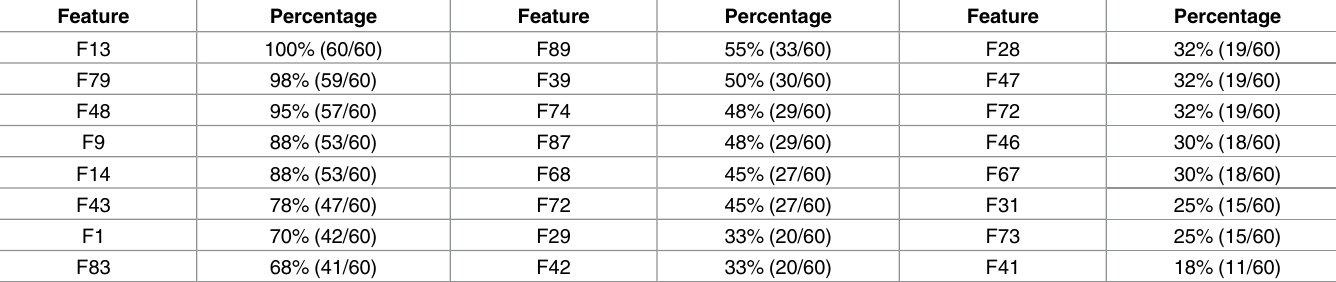
Table 3. List of 24 featuresthat were selected in leave-one-out training and testing cycles to test 60 cases.